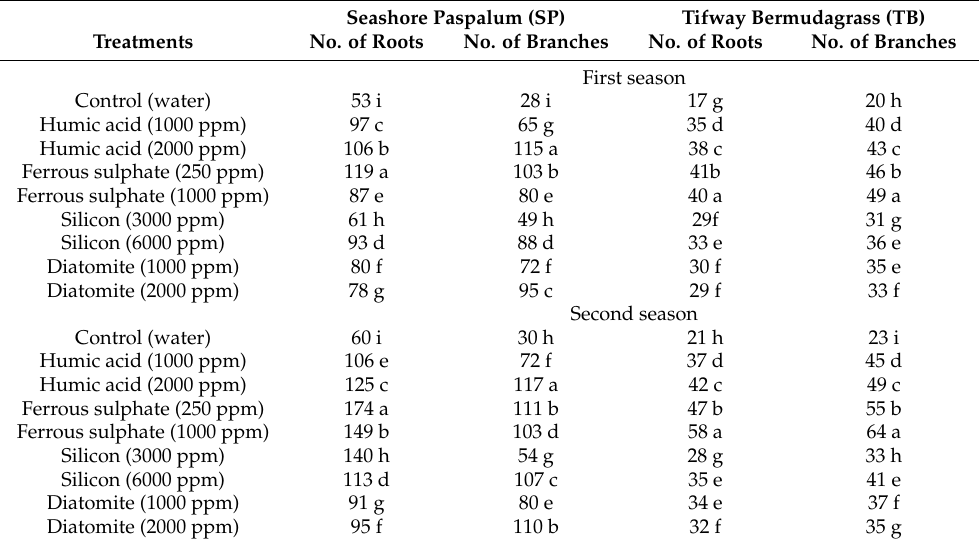
Table 3. Number of roots and branches of both species treated with different amendments during the studied seasons (area used for measuring was 100 cm 2